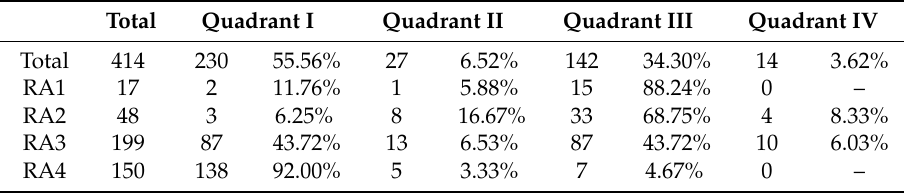
Table 3. Proportion of Open Space belonging to Each Quadrant in the Ring